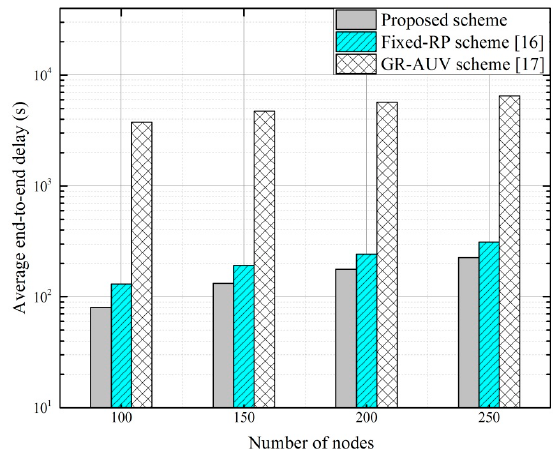
Figure 16. Average end-to-end delay versus the number of nodes.